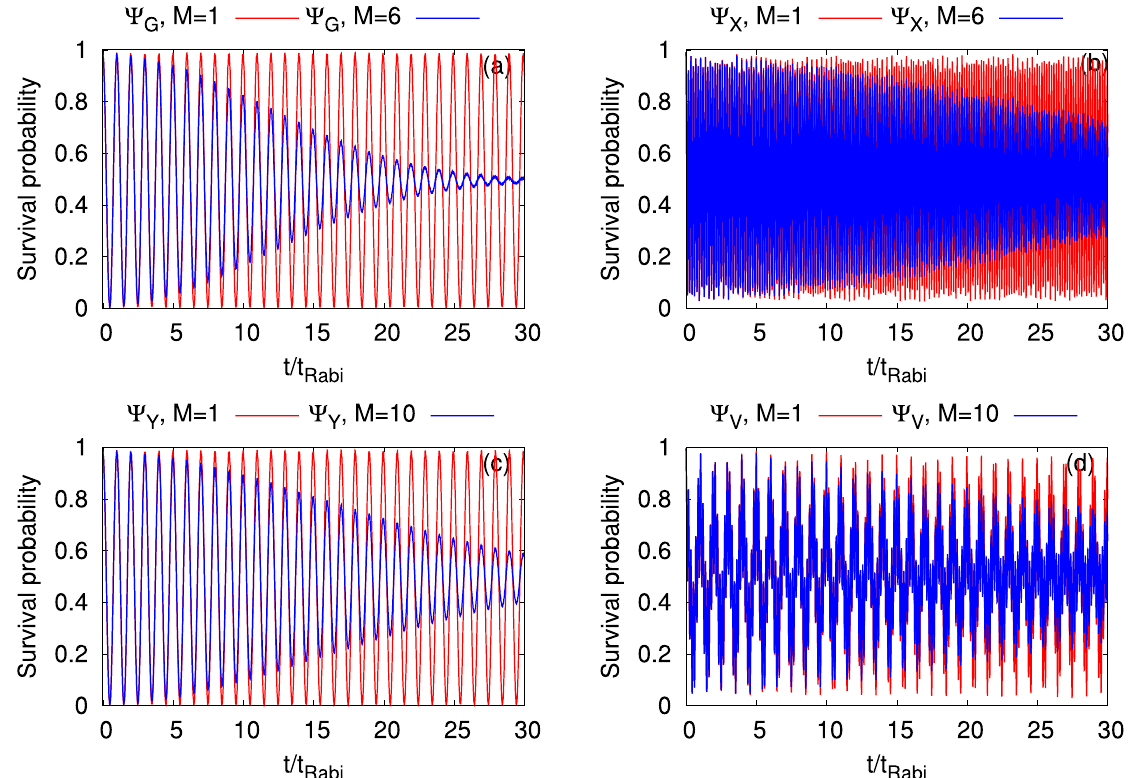
10 bosons in the left well of a Figure 10. Long-time dynamical evolution of the survival probability of N = symmetric 2D double-well for the initial states ( a ) (cid:31) G , ( b ) (cid:31) X , ( c ) (cid:31) Y , and ( d ) (cid:31) V . The interaction parameter 0.01 π . Mean-field results (in red) and corresponding many-body results (in blue). MCTDHB results are � = 6 time-adaptive orbitals for (cid:31) 10 time-adaptive orbitals for (cid:31) computed with M G and (cid:31) X , and M = Y and (cid:31) V . = The quantities shown are 1 � 2 ( t ) of (cid:31) V eventually becomes in time larger compared to the correspond- values for (cid:31) V , but the many-body N ˆ L Z